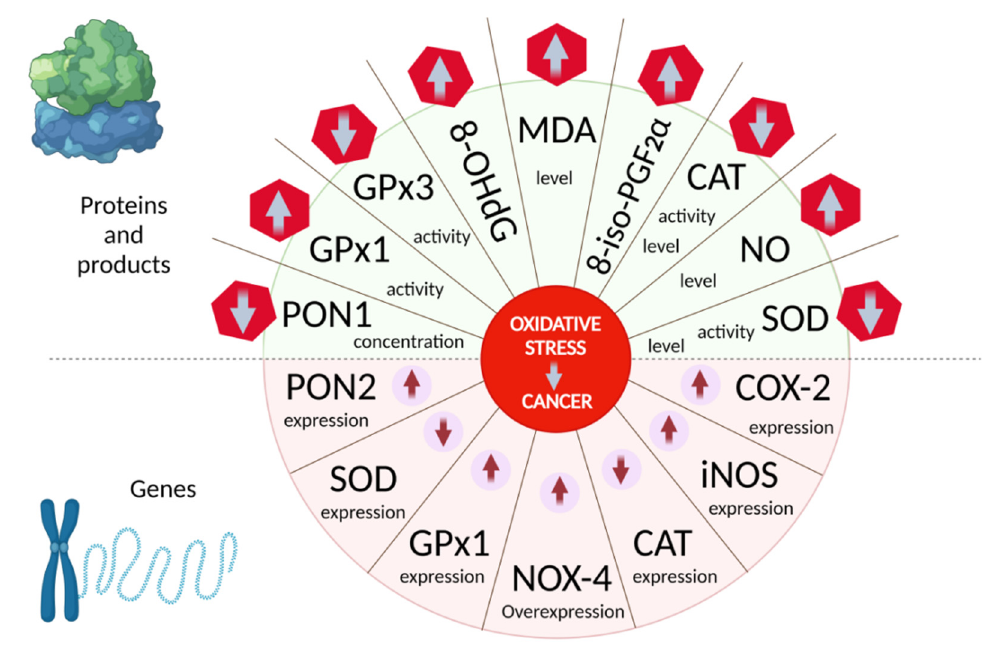
Figure 4. Schematic diagram reflecting the main commonly measured biomarkers of oxidative stress, impaired level, expression, and activity, which have a prognostic value in cancer progression.